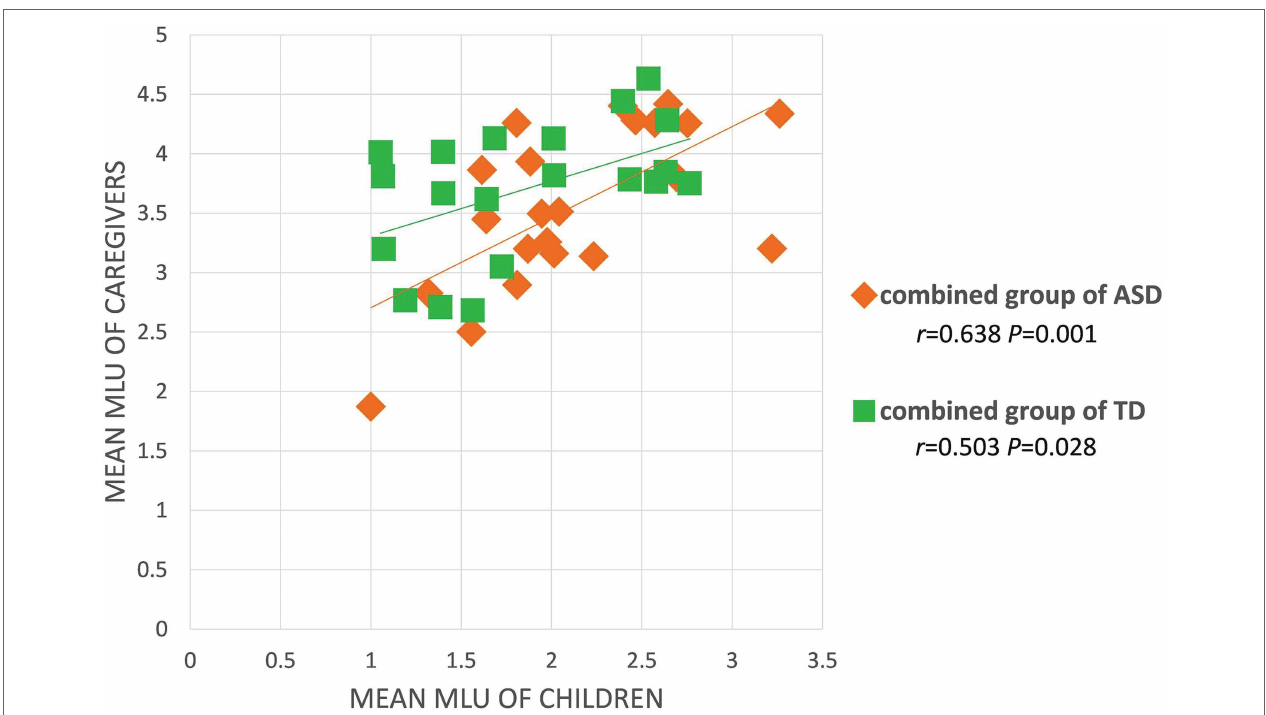
FIGURE 6 | Scatterplot of MLUs between caregivers and the combined group of TD children or children with